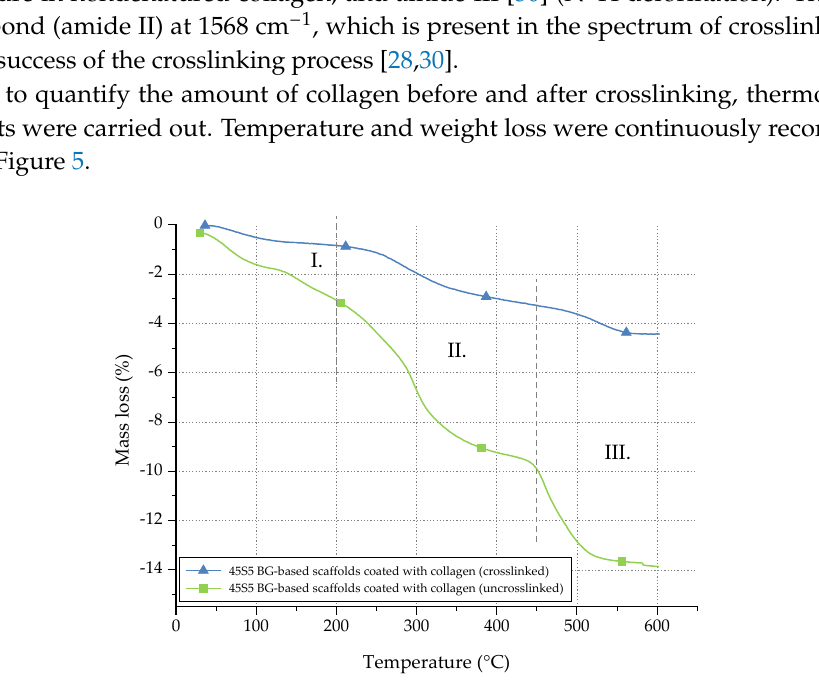
Figure 5. Mass loss of uncrosslinked and crosslinked collagen on 45S5 BG-based scaffolds during TGA.